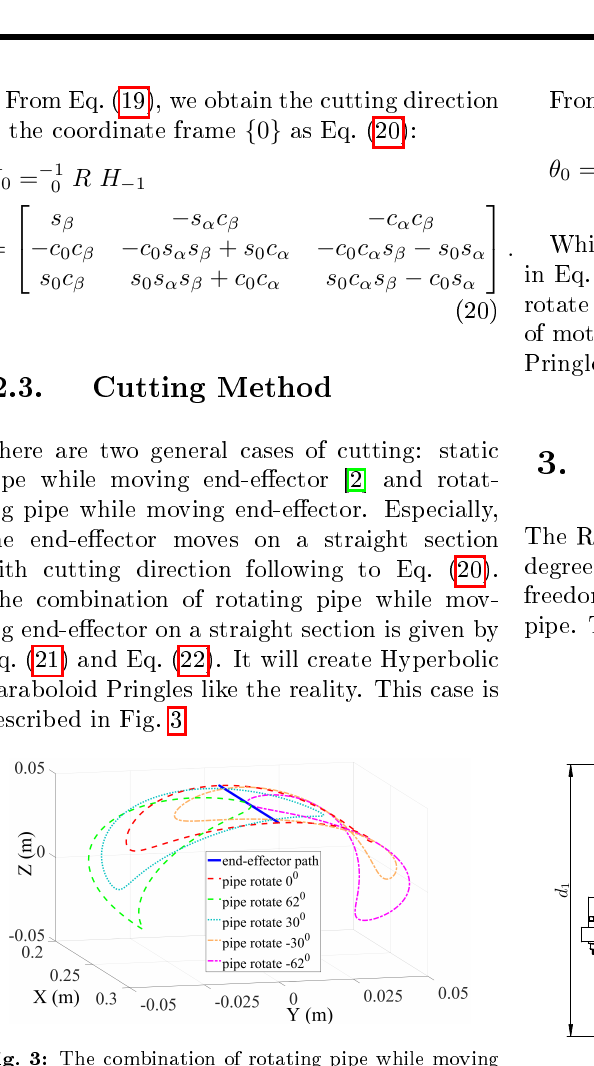
Fig. 3: The combination of rotating pipe while moving end-e(cid:27)ector on a straight section. Trajectory of end-e(cid:27)ector is a parallel straight section with X 0 axis, and is located right at the top of the pipe. The straight section belongs to plane ( X 0 , Z 0 ) , in which Y 0 = 0 and Z 0 = R 1 .